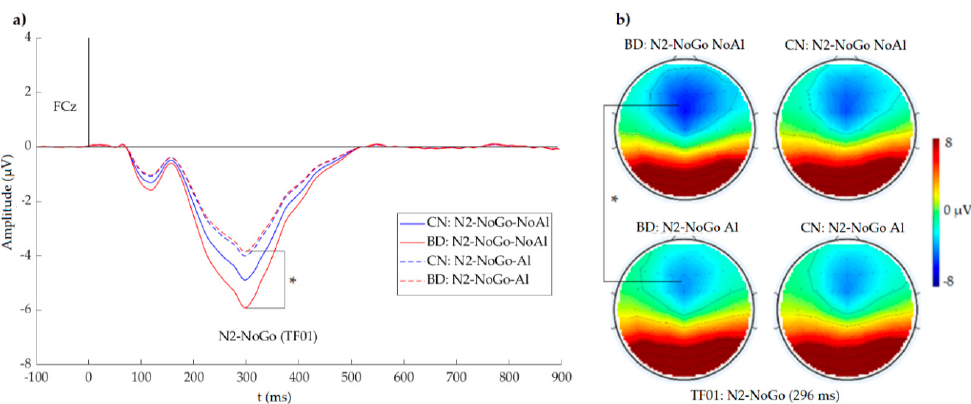
Table 4. Mean (SD) amplitude ( μ V) of each ERP component for different groups (control and binge drinkers) and type of stimulus (alcohol vs. nonalcohol; Go vs.